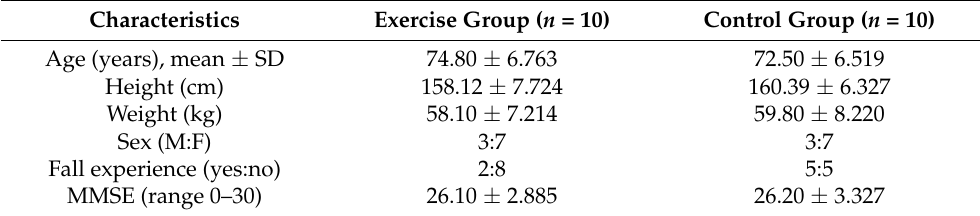
Table 2. Participant characteristics.